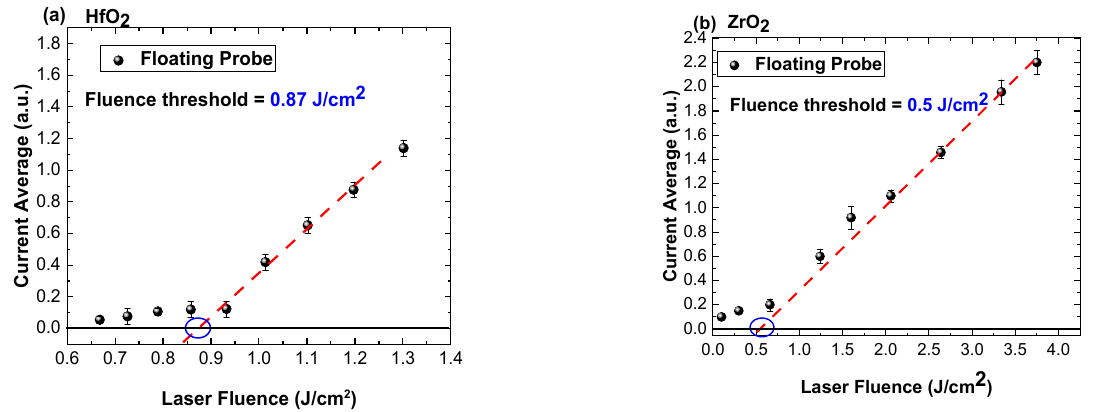
Figure 3. Current average representation as function of laser fluence for HfO 2 ( a ) and ZrO 2 ( b ).